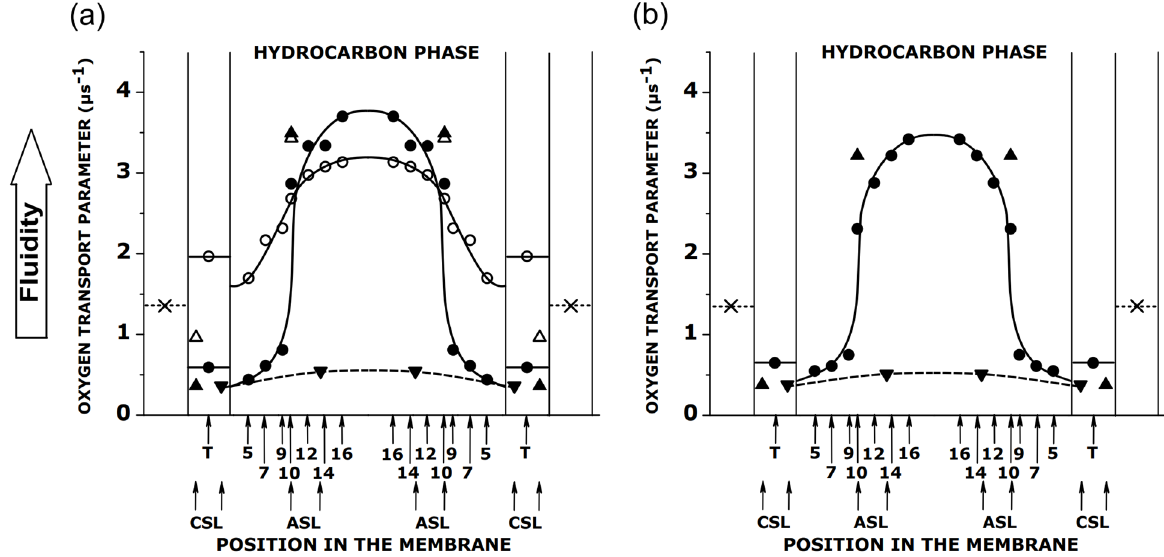
Figure 6. ( a ) Profiles of the oxygen diffusion-concentration products (OTPs) across membranes of multilamellar liposomes made of egg sphingomyelin in the absence ( ○ , ∆ ) and presence ( ● , ▲ , ▼ ) of a saturating amount of Chol. Symbols ( ○ , ● ) indicate profiles were obtained with n-PC, and symbols ( ∆ , ▲ , ▼ ) indicate data were obtained with ASL and CSL. Symbols ( ∆ , ▲ ) are for data from the PL bilayer, and symbols ( ▼ ) are for data from CBDs. It should be noted that the positions of the nitroxide moieties of ASL and CSL in the CBD are shifted toward the membrane center. A “sinking” of Chol molecules in the CBD was evaluated in [75] as about four C–C bonds deeper compared to Chol in the surrounding phospholipid bilayer; ( b ) Profiles of the OTPs across membranes of multilamellar liposomes made of the total lipid extracts from cortical fiber cell membranes of eye lenses from the group of 61–70-year-old human donors. Symbols ( ● , ▲ ) indicate profiles were obtained with n-PC, ASL, and CSL in the PL bilayer, and symbols ( ▼ ) are for data obtained with ASL and CSL from CBDs. The symbol (x) indicates an OTP in water. All profiles were obtained at 37 °C. At ages ranging from 60 to 70 years, human lens fiber cell membranes contain ~70% sphingolipids [81]. Approximate locations of the nitroxide moieties of the spin labels are indicated by arrows (numbers for n-PC and “T” for T-PC). Data points for ( a ) are adapted from [82] with permission of the Elsevier Science & Technology Journals and for ( b ) are adapted from [60] with permission of the Taylor and Francis Group.